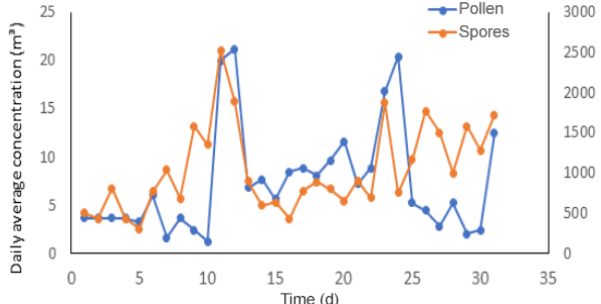
Figure 6. Daily average concentrations of pollen and spore numbers for October 2015, based on data collected at Tel Aviv University’s monitoring station in the botanical gardens on campus (data cour- tesy of Amram Eshel, the Laboratory for Pollen Monitoring, Tel Aviv University).